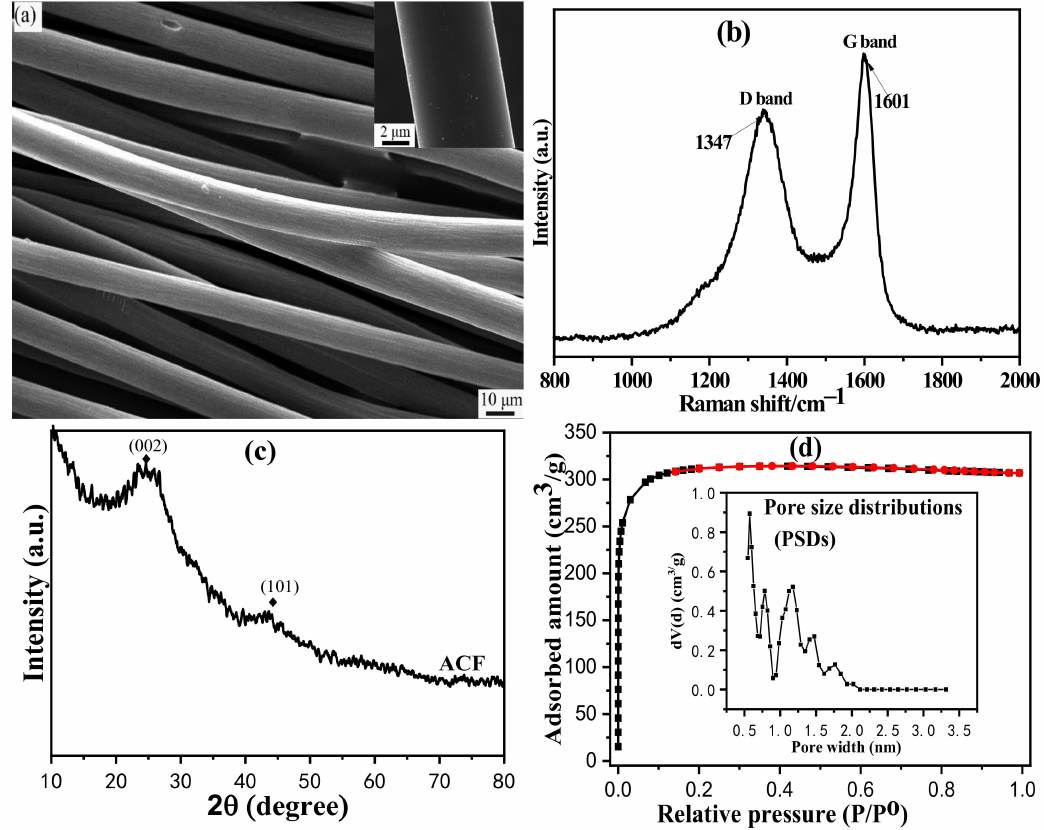
Figure 3. Characterizations of the pristine ACF, ( a ) SEM micrograph, ( b ) Raman spectrum, ( c ) XRD pattern, ( d ) nitrogen adsorption/desorption isotherm curves, and pore size distributions